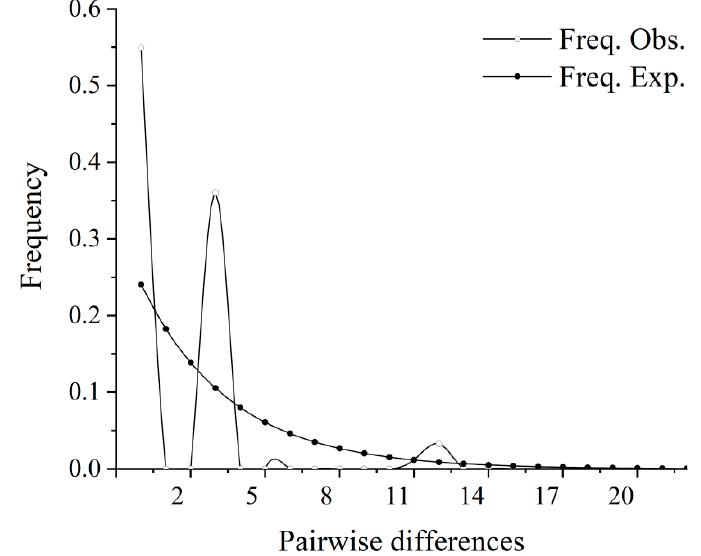
Figure 5. Mismatch distribution of C. alburnus based on COI gene sequences.